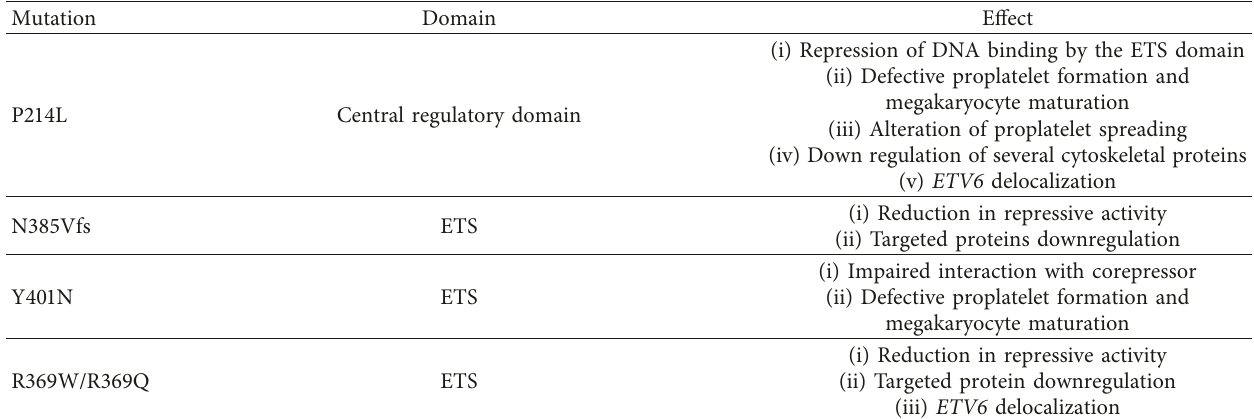
Table 3: Main hotspot mutations in the ETV6 gene and their impact on the protein.